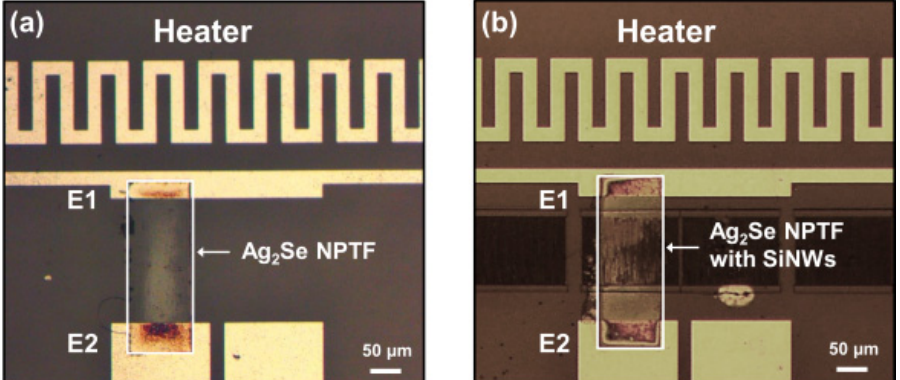
Figure 4. Optical image of a thermoelectric platform comprising a meander line patterned heater, two electrodes (E1, E2), and thermoelectric channels of ( a ) the Ag 2 Se NPTF alone and ( b ) the Ag 2 Se NPTF embedded with SiNWs.